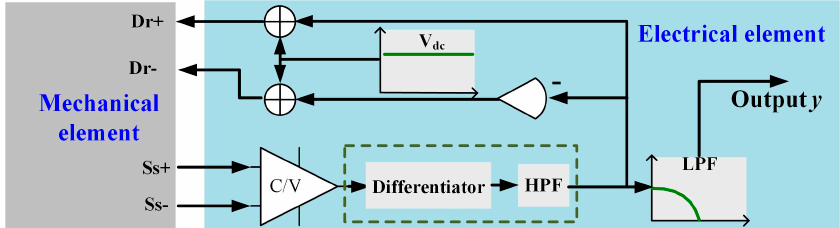
Figure 1. Schematic of a typical microelectromechanical system (MEMS) resonant accelerometer sensor.